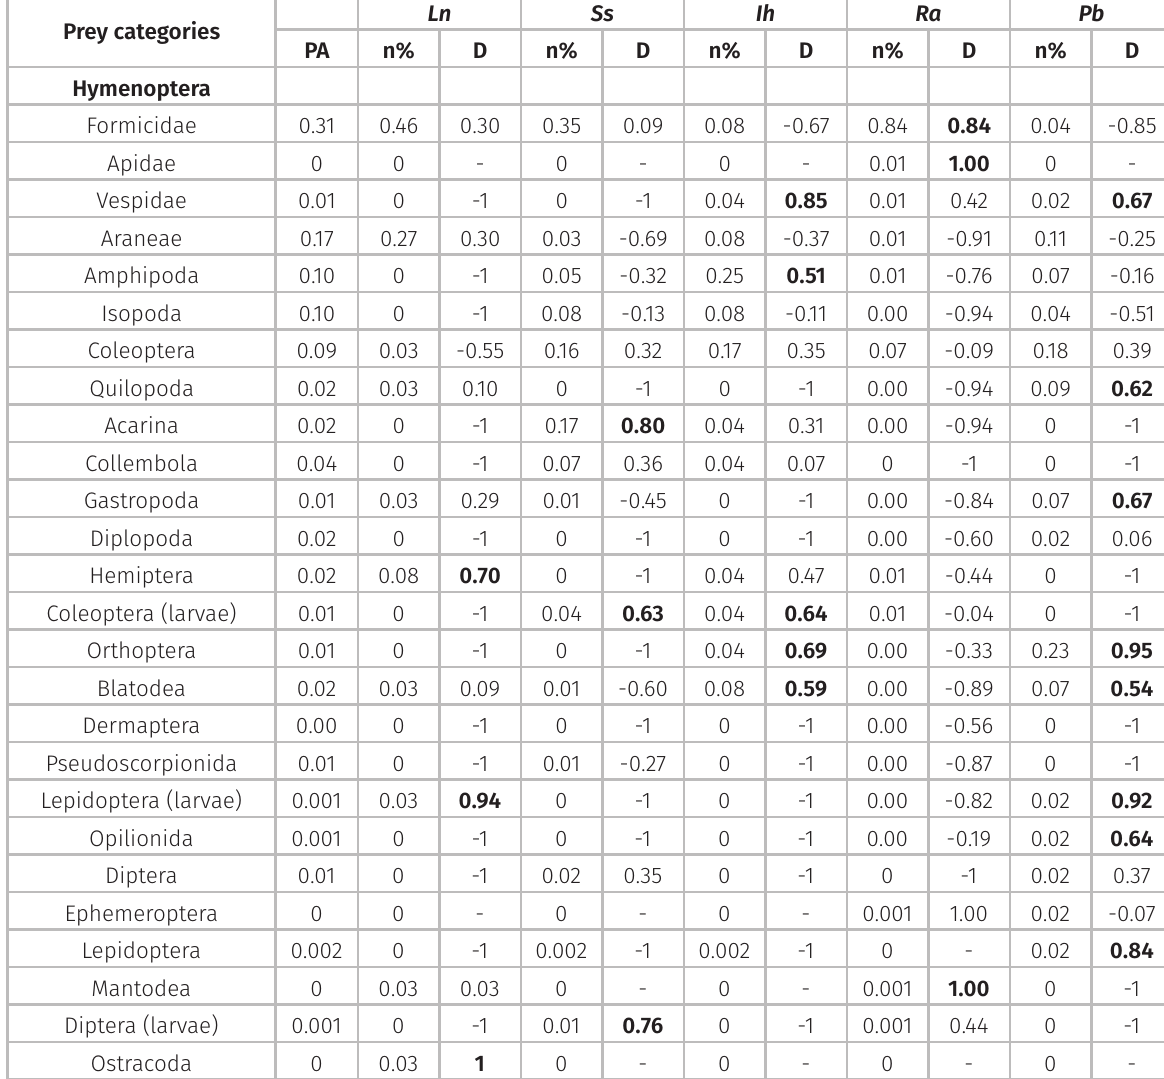
Table II. Prey electivity index of litter species Leptodactylus notoaktites ( Ln ), Proceratophrys boiei ( Pb ), Scythrophrys sawayae ( Ss ), Rhinella abei (Ra), Ischnocnema henselii ( Ih ). Legend: PA = Prey availability of leaf litter, n% = number of prey, D = Jacobs electivity index. Red values indicate prey